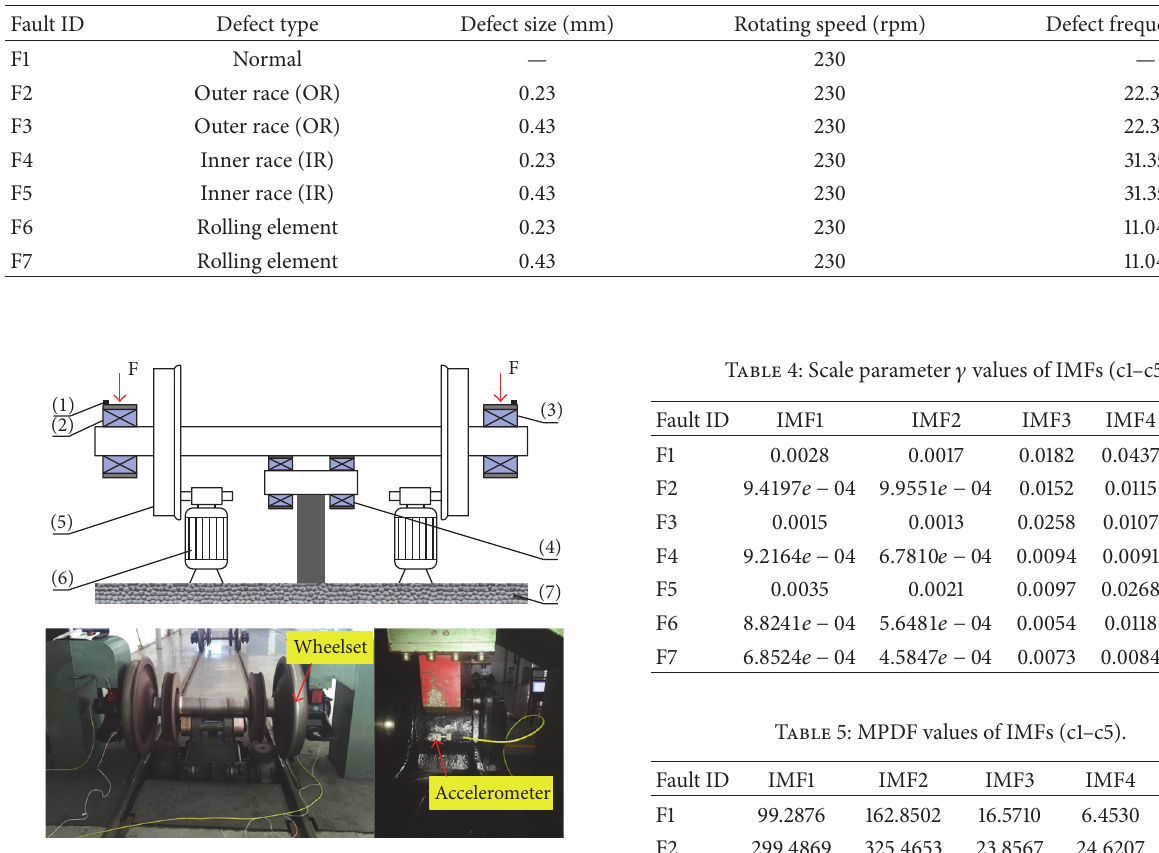
Figure 5: Experimental setup for vibration signal acquisition. (1) Accelerometer; (2) normal axle box bearing; (3) fault axle box bearing; (4) installation of wheelset; (5) friction wheel; (6) induction motor; (7) ground. Table 3: Characteristic exponent 𝛼 values of IMFs (c1–c5).